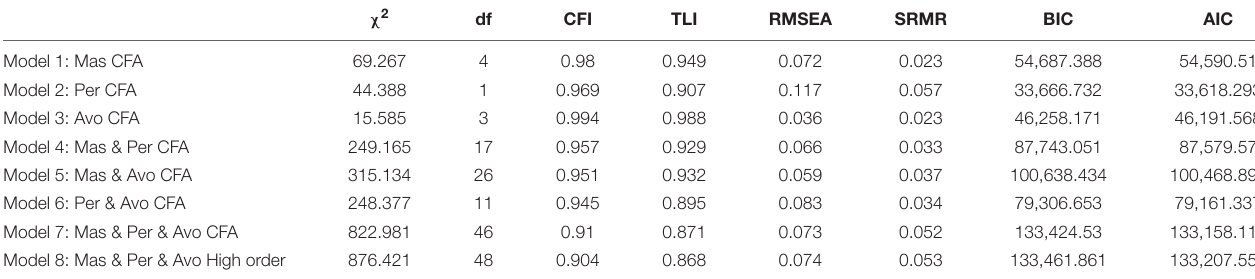
TABLE 3 | Confirmatory factor analysis (CFA) for single-level factor